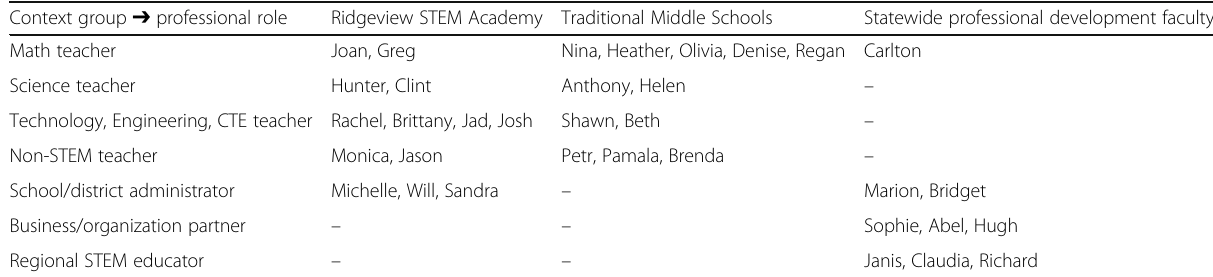
Table 1 Pseudonyms of participants by context group and by professional